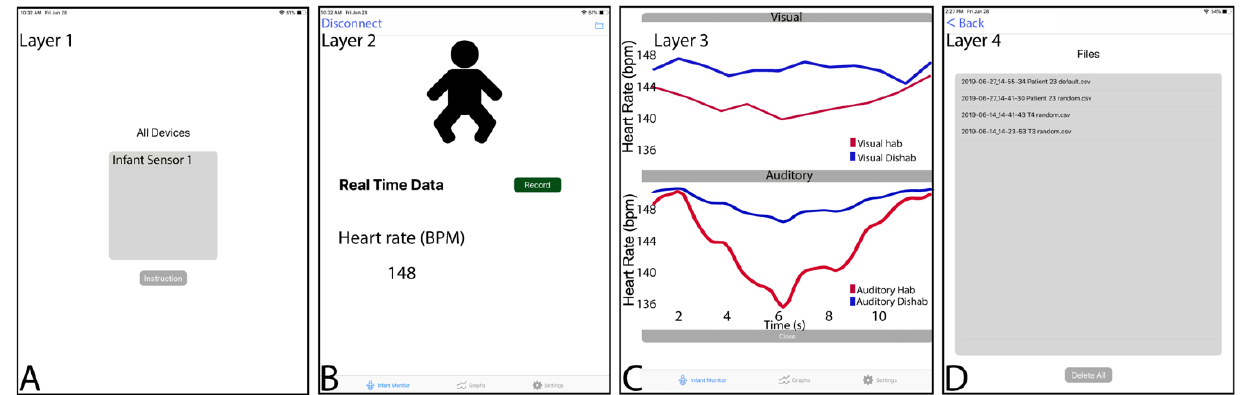
Figure 3. COR mo bile app running on a 10” iOS tablet. ( A ) The primary layer shows a COR sensor listed during BLE advertising, just before the connection between the sensor and the app is estab- lished. When the user clicks on the COR sensor name listed under “All Devices,” such a connection between both ends is established. ( B ) Since the connection between the sensor and the app, the user can see the heart rate information displayed on the left under “Heart rate (BPM).” ( C ) When the experiment is completed, the user gets feedback regarding deceleration as the averaged BPM for the first three trials for habituation and dishabituation at each stimuli category. ( D ) This final layer shows the experiment stored in the iOS device and provides the option to select and share a selected experiment by email.